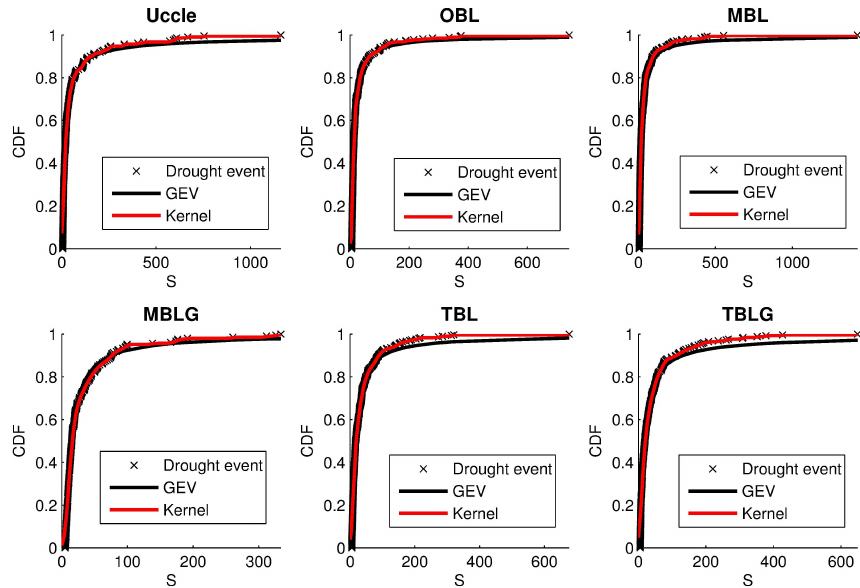
Fig. 6. GEV and Kernel cumulative distribution functions of drought severity S .